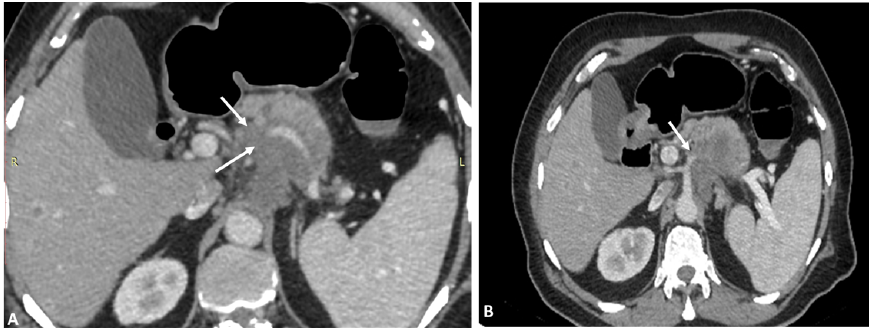
Figure 7. ( A ) Axial phase maximum intensity projection (MIP) (64-row scanner CT angiography) image of the abdominal region showing tumor infiltrating pancreatic head indicated by the arrow. ( B ) Axial phase maximum intensity projection (MIP) (64-row scanner CT angiography) image of the abdominal region showing tumor invading the artery indicated by the arrow.